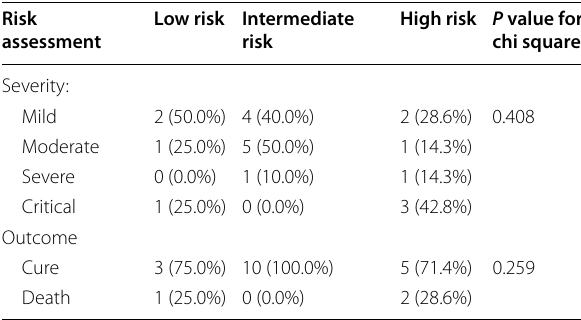
Table 3 Association between the risk stratification for mortality in PH patients and COVID-19 severity and outcome